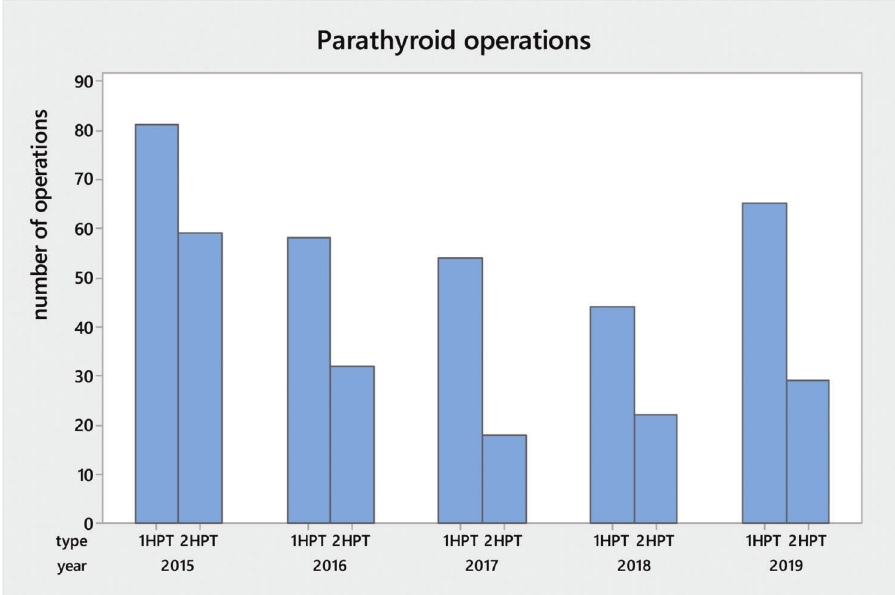
Figure 1 - Annual Parathyroid operations before the 2020 COVID-19 pandemic (1HPT=primary hyperparathyroidism, 2HPT=renal